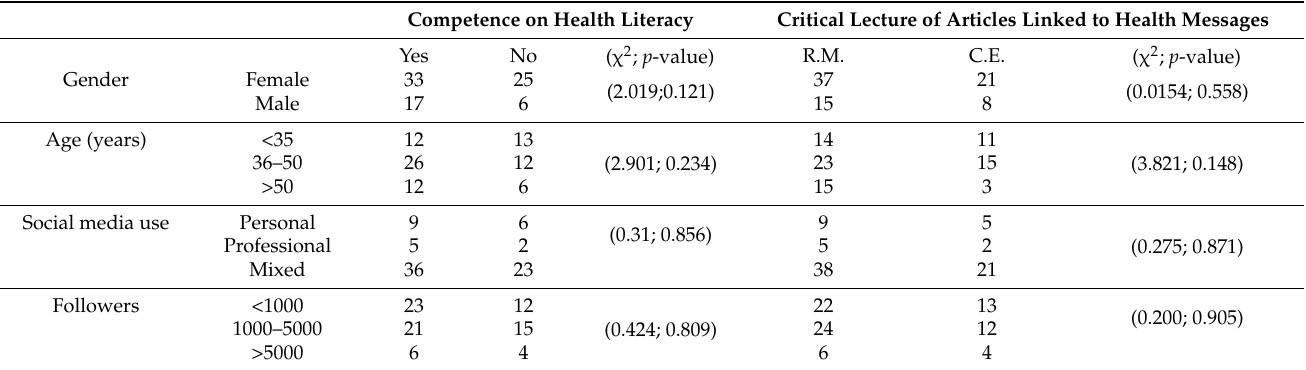
Table 2. Influence of sociodemographic characteristics on the frequency of checking the reliability of health information with scientific papers